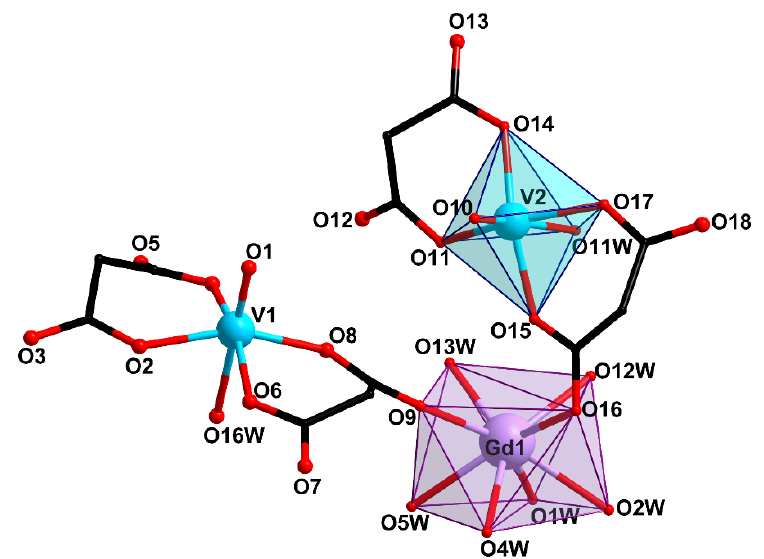
Figure 3. Structure of trinuclear unit {GdV 2 } − in compound 3 (H atoms and cyclic fragments of the carboxylate ligands are not shown).